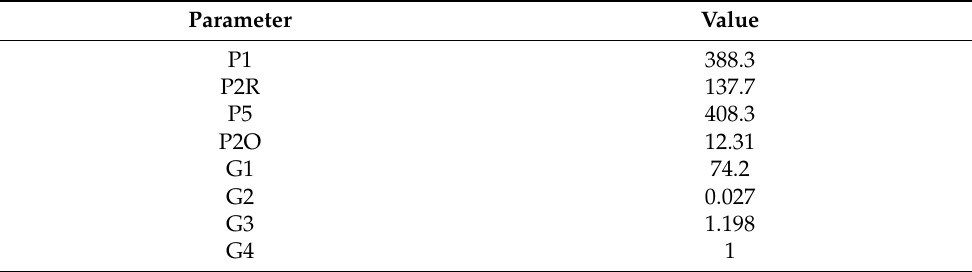
Table 2. The genetic coefficient for Ciherang rice